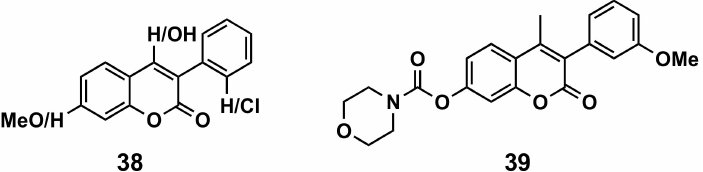
Figure 17. 3-Phenylcoumarins as antiviral